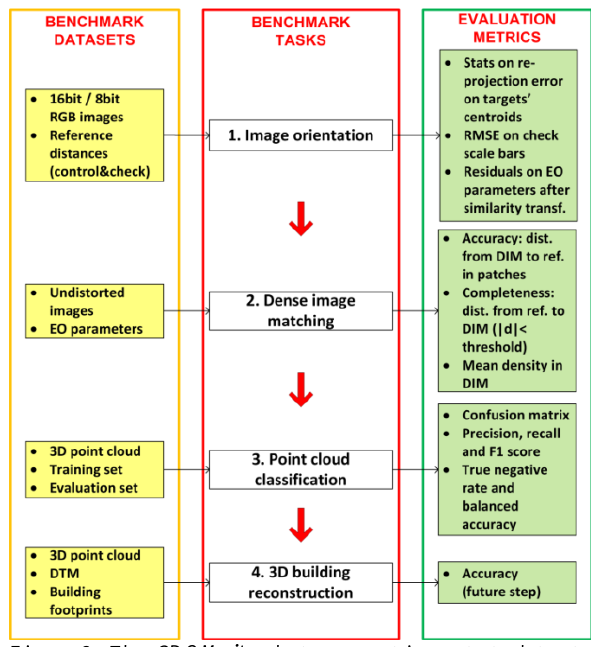
Figure 2. The 3DOMcity photogrammetric contest: datasets, tasks and corresponding evaluation metrics.